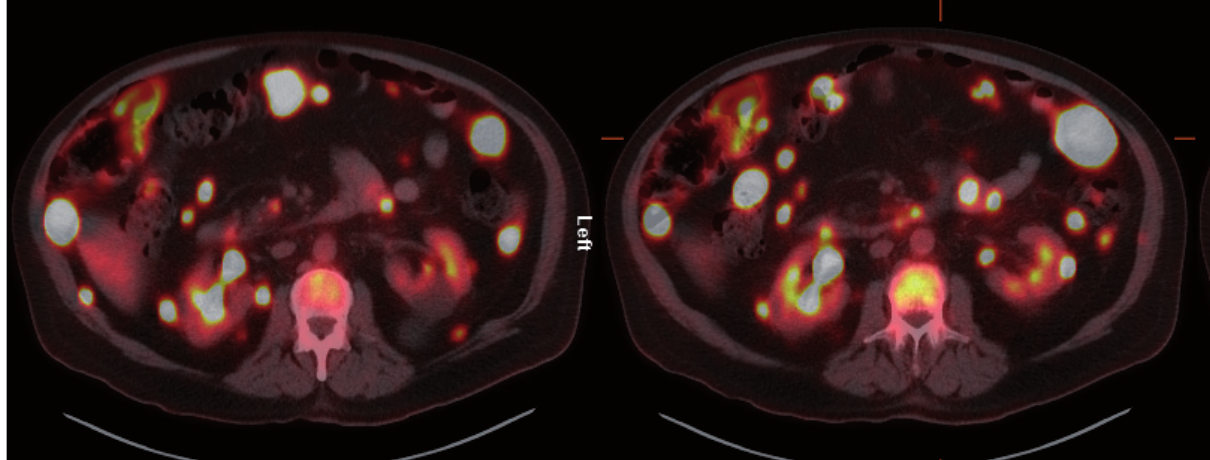
Figure 2. Axial 18 F-FDG PET/CT fusion images. Foci of markedly increased 18 F-FDG uptake are shown in the peritoneal cavity, and in exophytic lesions in the kidneys